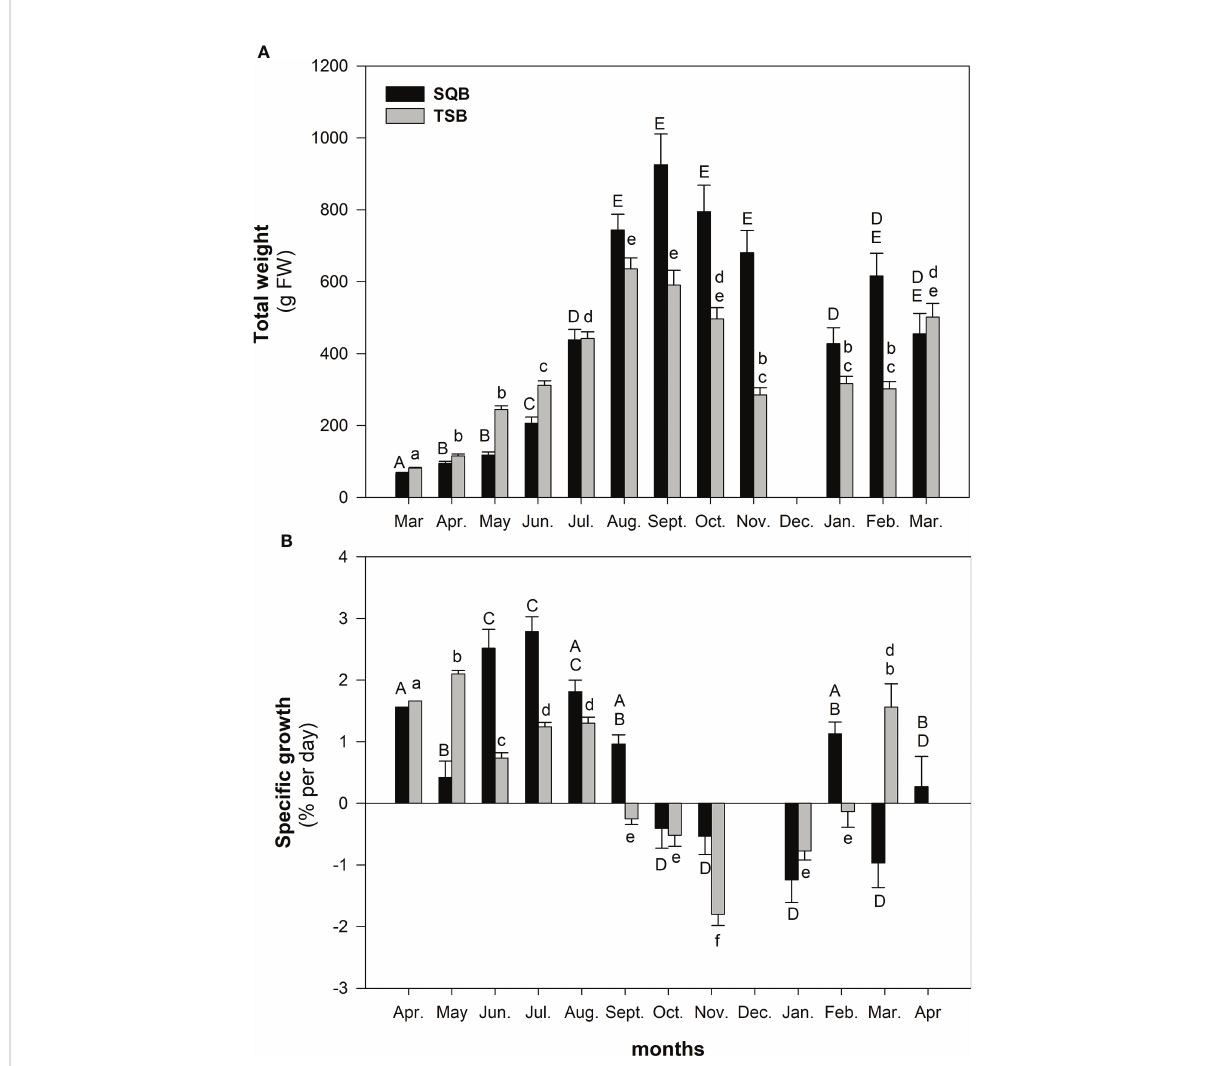
FIGURE 2 Changes in (A) weight (g FW) and (B) speci fi c growth rate (% per day) of Eisenia arborea sporophytes cultured in San Quint ı ́ n Bay (SQB) and Todos Santos Bay (TSB). Different uppercase and lowercase letters indicate statistically signi fi cant differences (one-way ANOVA, post hoc Student Newman Keuls test) obtained at different sampling times during cultivation. Values are means and standard